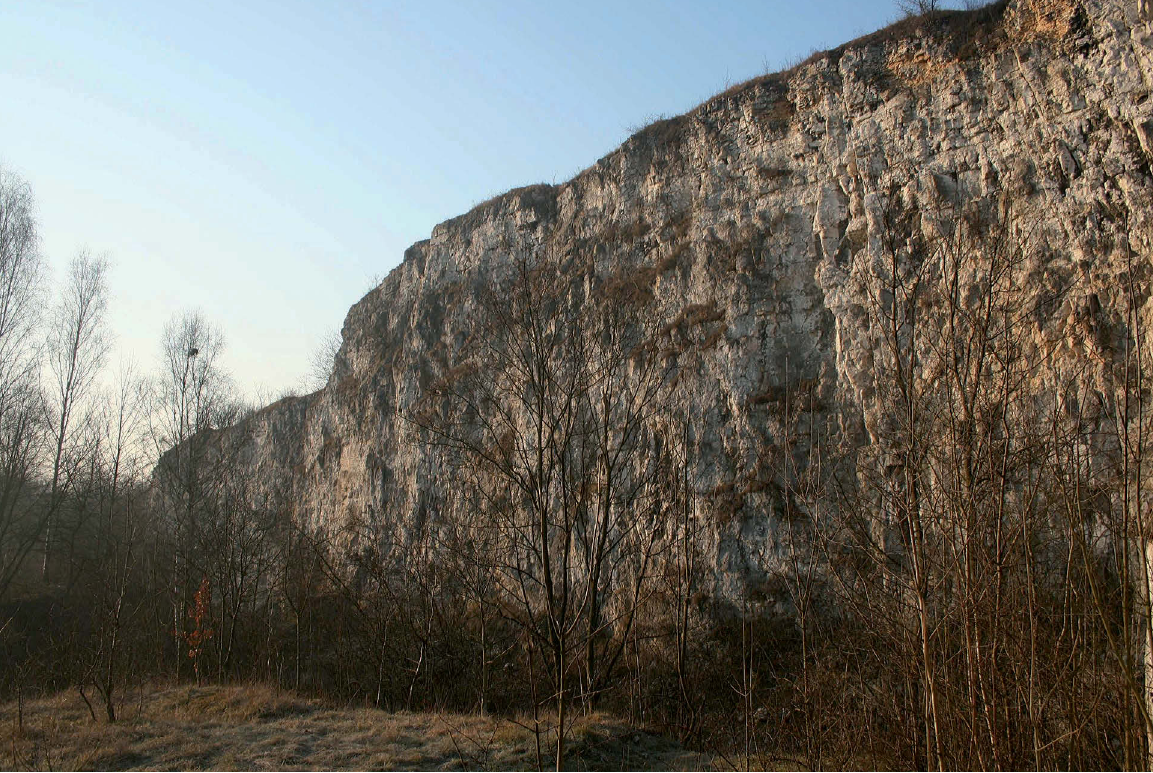
Fig. 4. Renaturalised landscape in the area of “Skałki Twardowskiego”